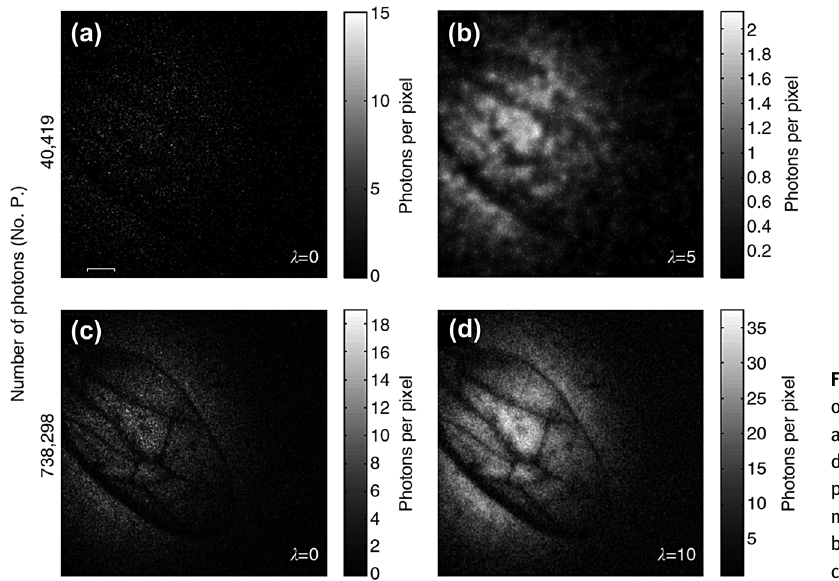
Figure 18: Heralded single-photon imaging of a wasp wing.